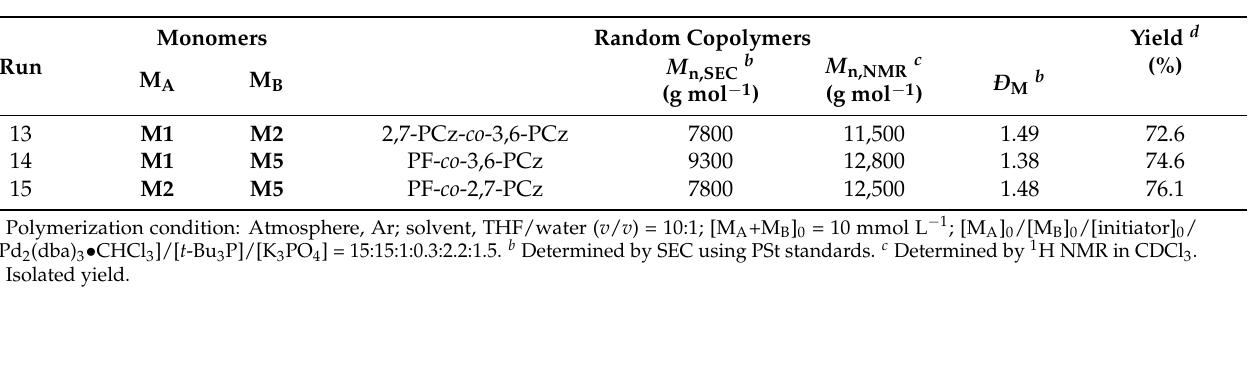
Table 2. Synthesis of PCz and PF-containing random copolymers a